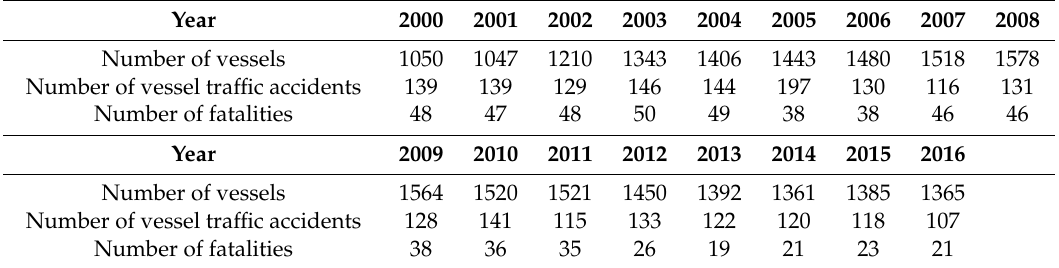
Table 1. Vessel traffic accident data.